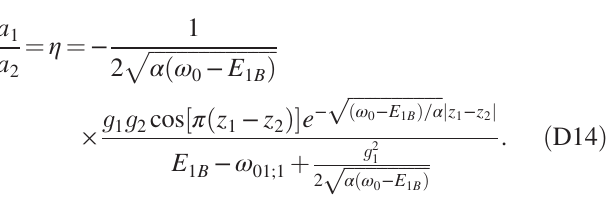
ffiffiffiffiffiffiffiffiffiffiffiffiffiffiffiffiffiffiffiffiffiffiffiffiffi α ð ω − E 0 1 B Þ